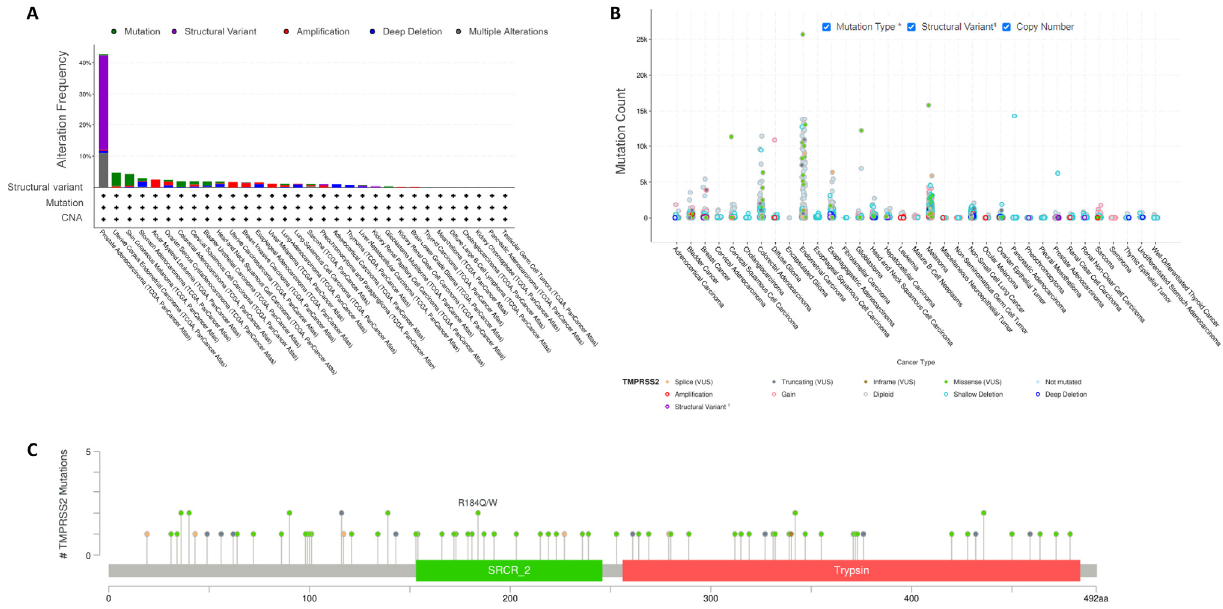
Figure 3. TMPRSS2 mutation in pan-cancers. ( A ) Cancer type summary for TMPRSS2 mutations, including 32 categories (cancer study) based on filtering. ( B ) Plots for TMPRSS2 mutation types. ( C ) Overview of mutations in TMPRSS2 . CNA: Copy number alterations (CNA) data.